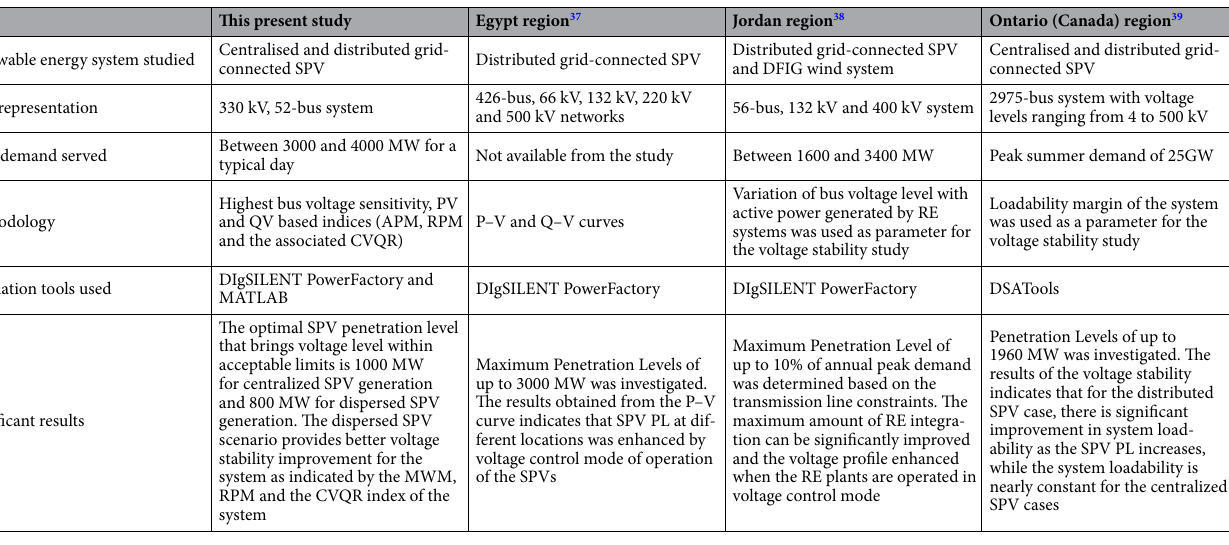
Table 3. Comparison of this present study with studies in other